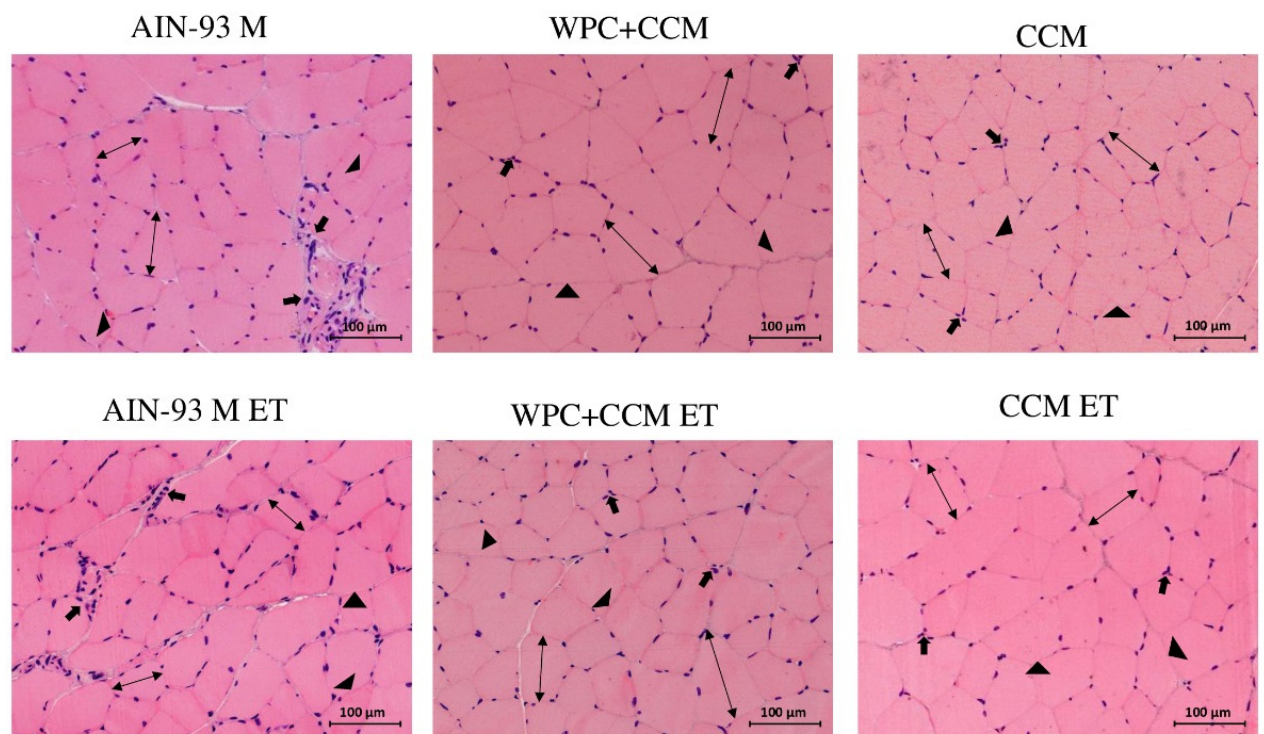
Figure 5. Cross-section of the muscle of rats that were or were not submitted to the exhaustive test.